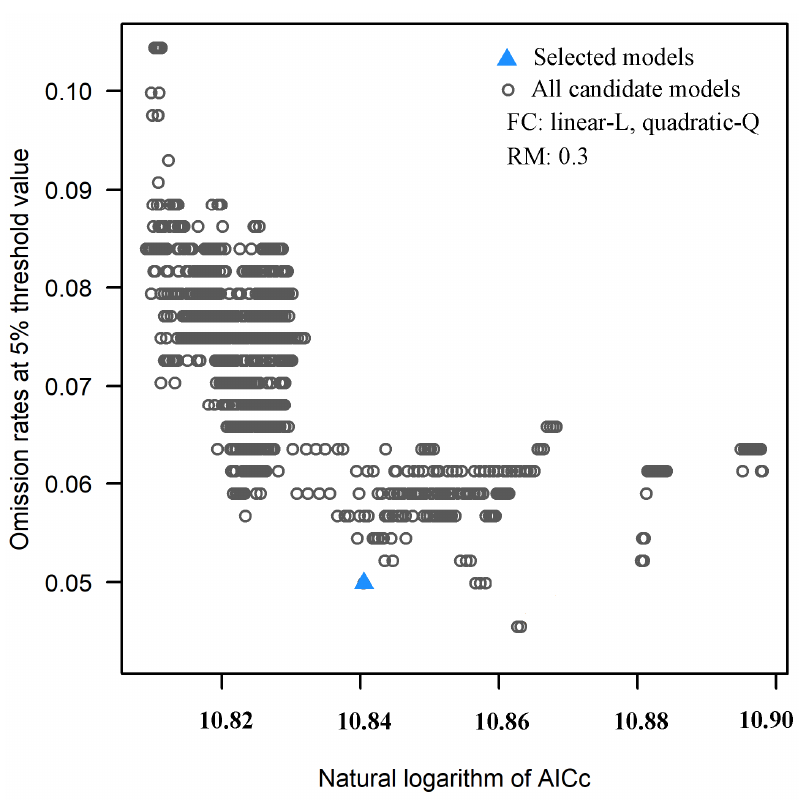
Figure 3. Omission rates and AICc values for all, nonsignificant, and selected “best” candidate models for Helicoverpa zea .